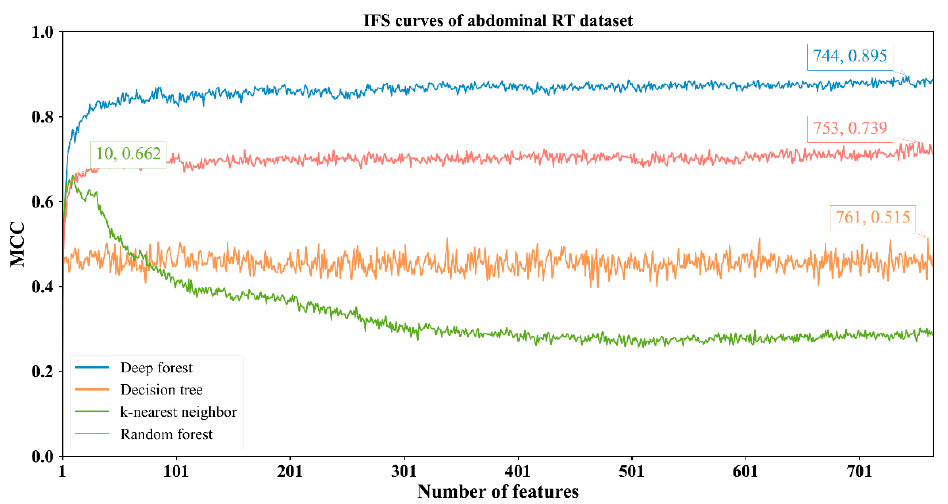
Figure 2. IFS curves with different classifiers on the different numbers of methylation features for abdominal RT methylation dataset. DF achieves the highest MCC value of 0.895 when the top 744 features are used.